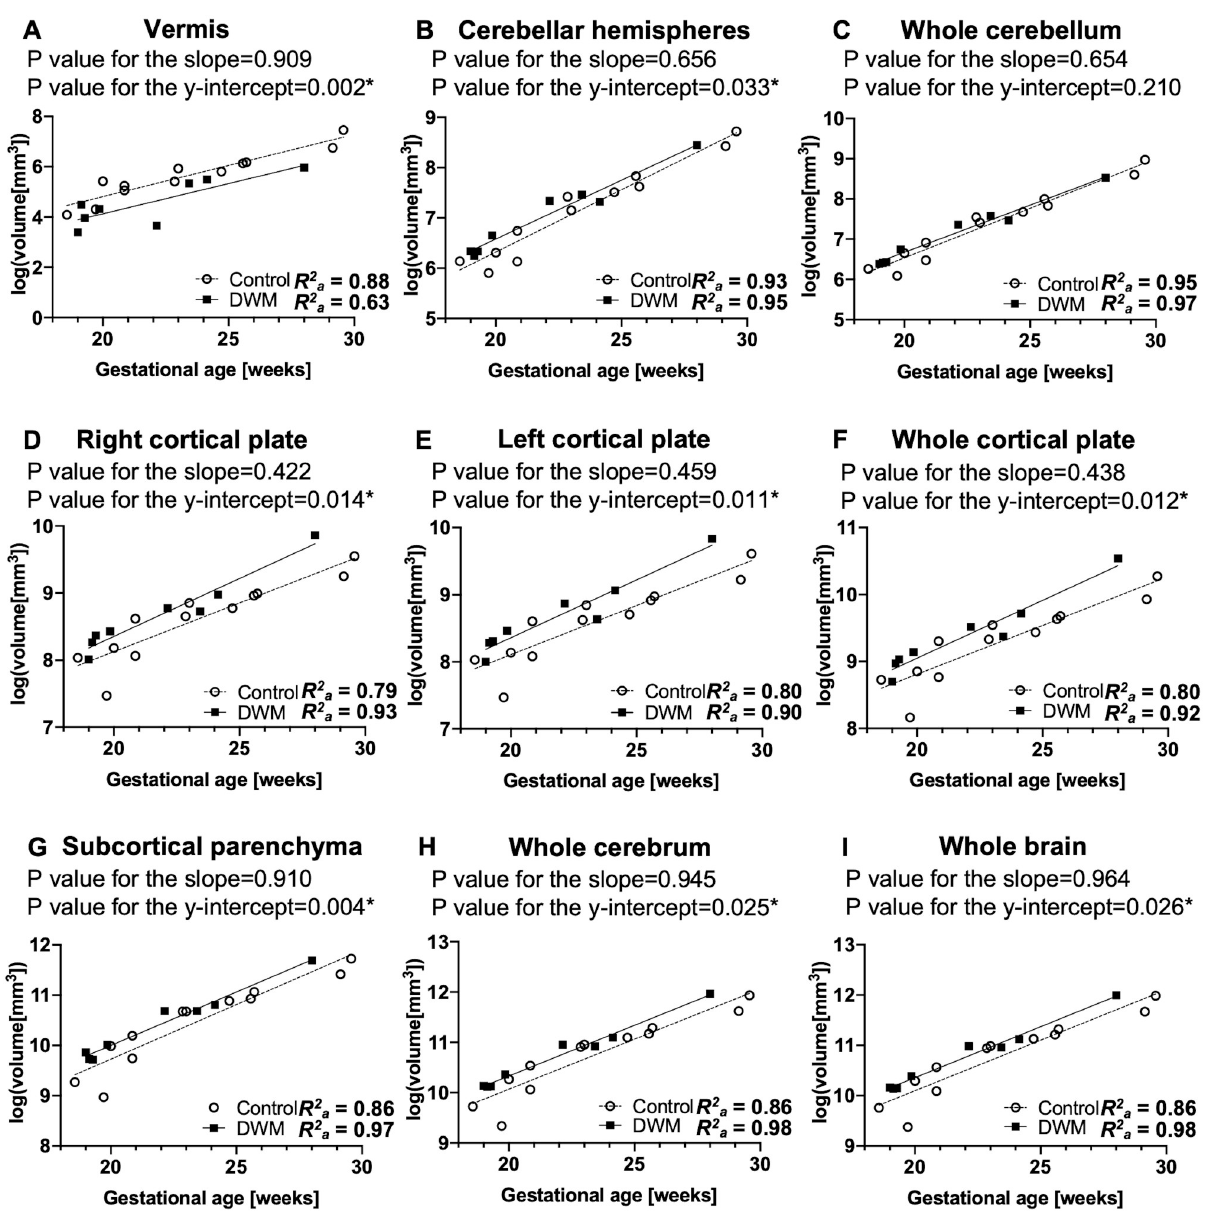
Fig 3. Regional growth trajectories in fetuses with DWM (n = 8) and control fetuses (n = 12) in subgroup analysis that excluded fetuses with agenesis of the corpus callosum (ACC). A logarithmic transformation of the volume data was performed before fitting the linear regression model in both the DWM and control groups. Similar to results of the whole-group analysis (Fig 2), the growth trajectory of the whole cortical plate (F) was significantly larger in fetuses with DWM than in control fetuses. In the subgroup analysis, both the right (D) and left (E) cortical plate were significantly larger in fetuses with DWM than in control fetuses. Further, the growth trajectories of the cerebellar hemispheres (B), subcortical parenchyma (G), whole cerebrum (H), and whole brain (I) were significantly larger in fetuses with DWM than in control fetuses. No significant differences were observed in growth trajectories of the whole cerebellum (C) between fetuses with DWM and control fetuses in the subgroup analysis.